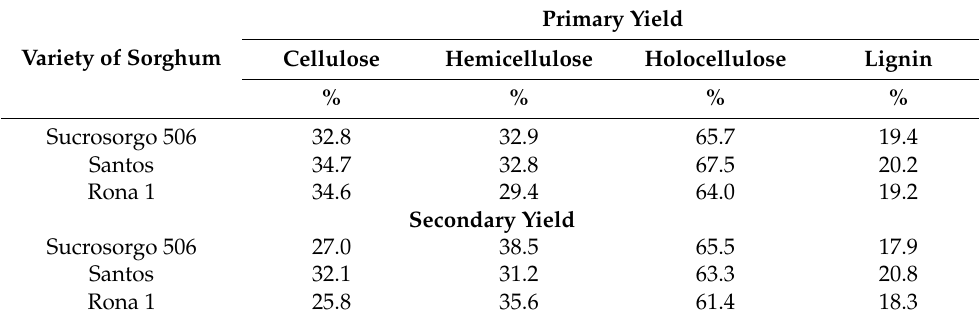
Table 8. Chemical composition of biomass of sorghum cultivars grown in primary and secondary crops for the production of bioethanol [70]. Primary Yield Variety of Sorghum Cellulose Hemicellulose